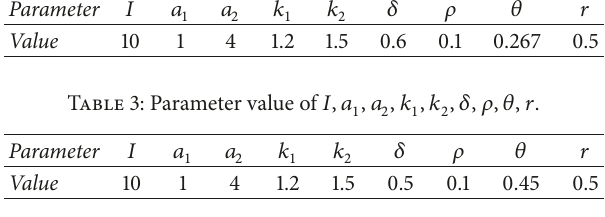
Table 2: Parameter value of 𝐼 , 𝑎 1 , 𝑎 2 , 𝑘 1 , 𝑘 2 , 𝛿 , 𝜌 , 𝜃 , 𝑟 . Parameter 𝐼